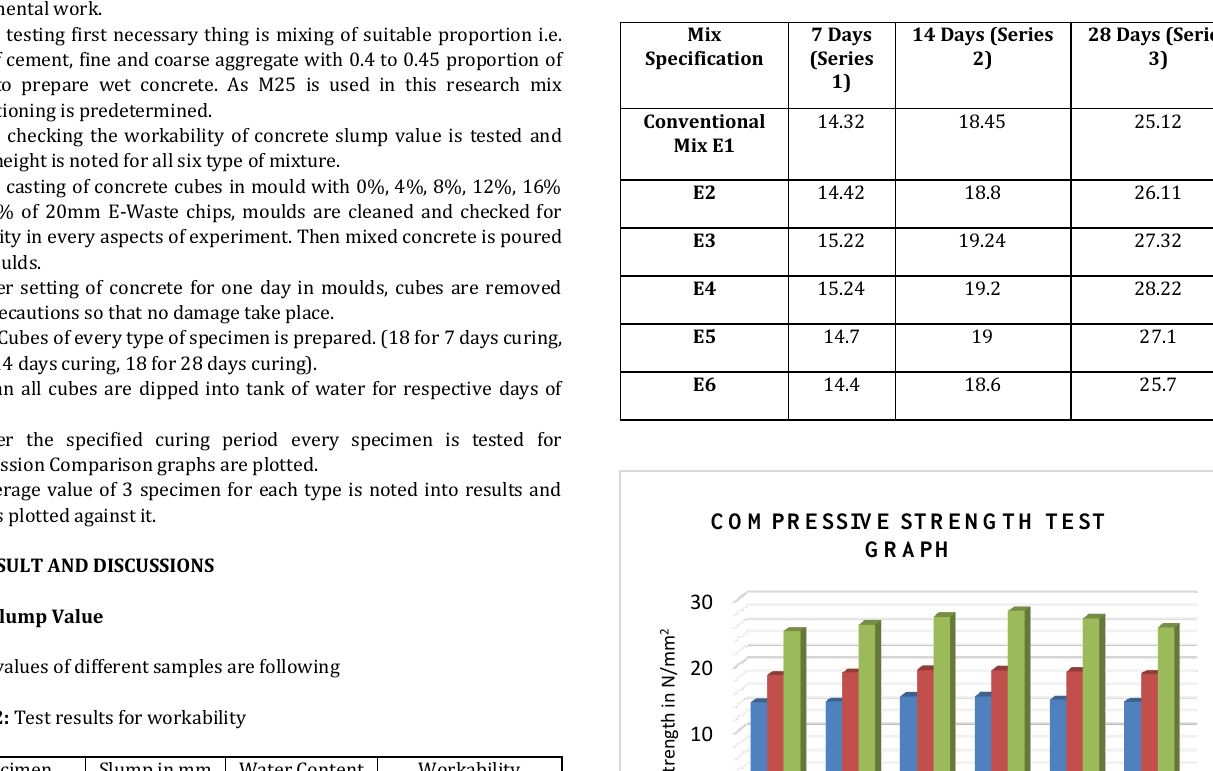
Table 3: Test results for Compressive strength